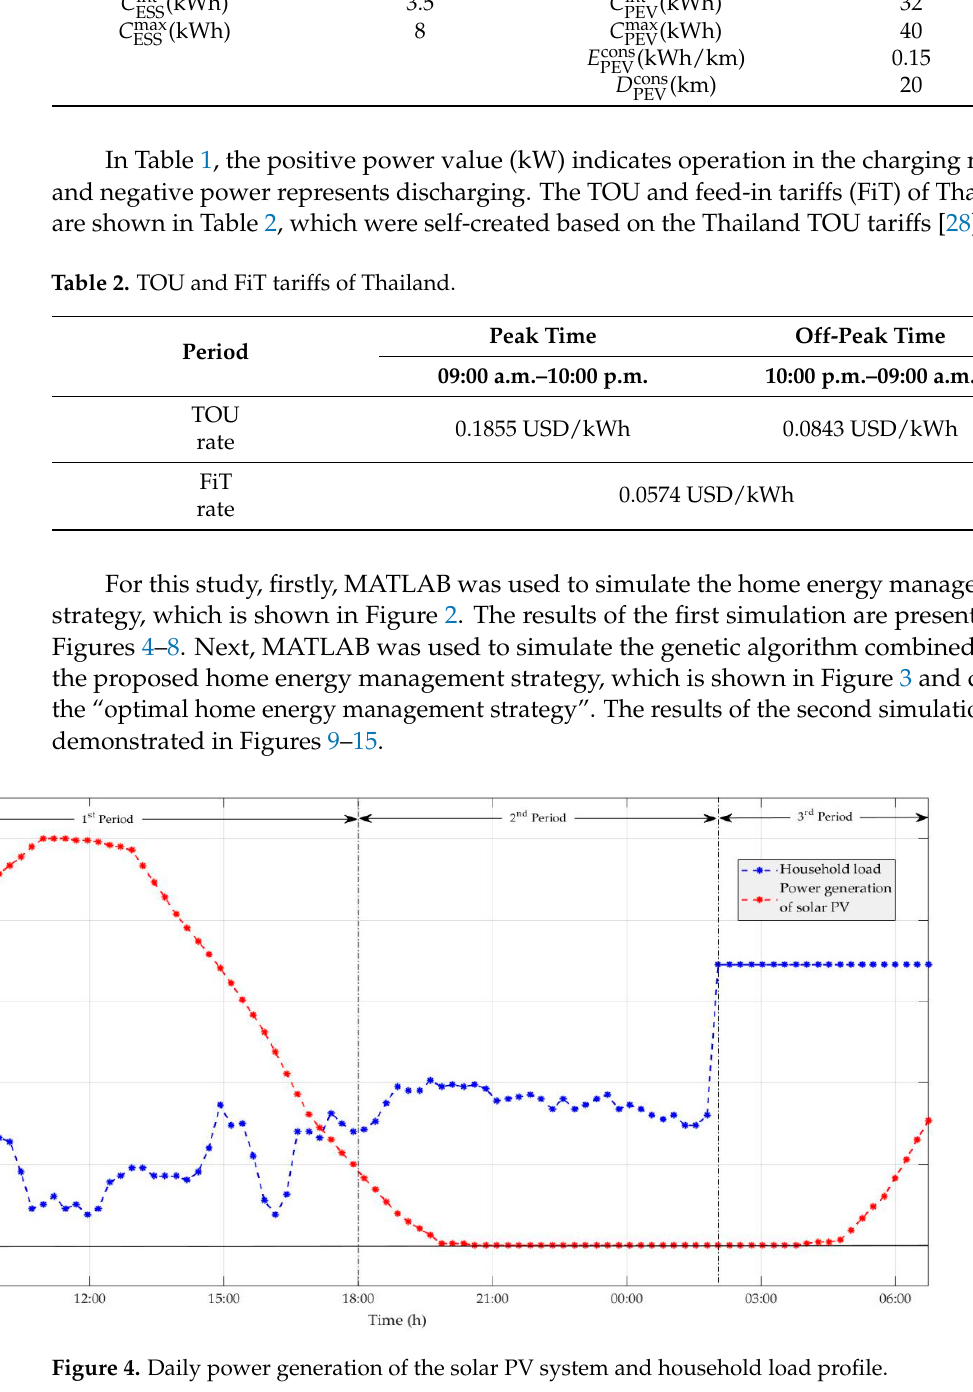
Figure 5. Energy management results of the strategy without GA when there is surplus and insufficient power in a household in each time slot.